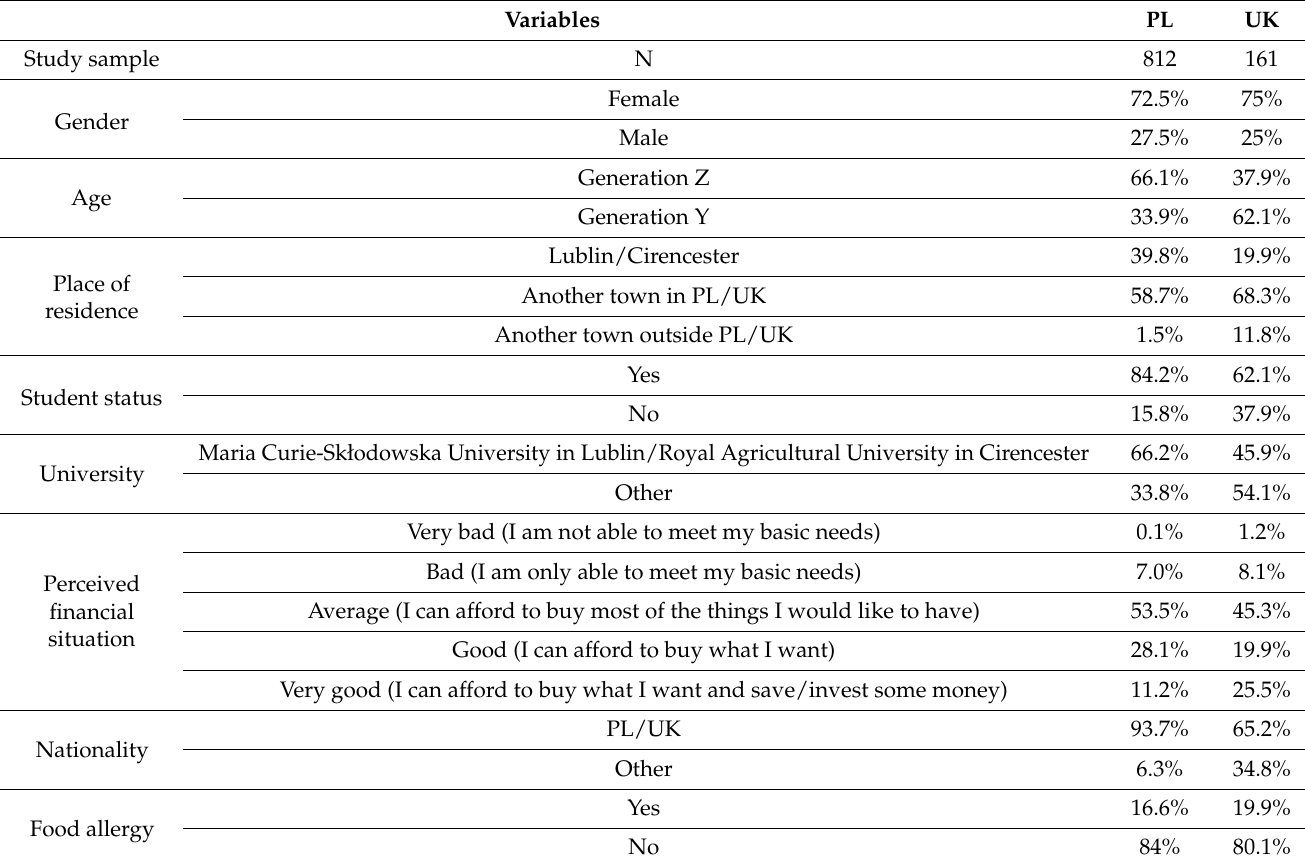
Table 1. Demographic structure of the sample from the UK and the PL